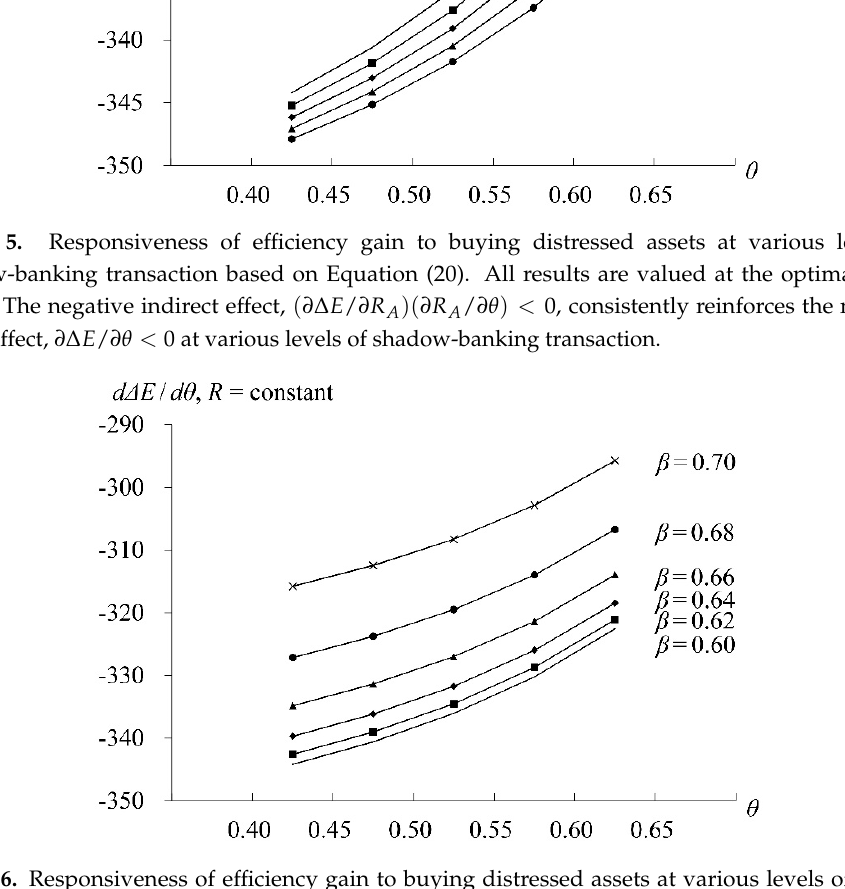
Figure 6. Responsiveness of efficiency gain to buying distressed assets at various levels of barrier based on Equation (20). All results are valued at the optimal R A of 5.60%. The negative indirect effect, ( ∂ ∆ E / ∂ R )( ∂ R ) < 0, consistently reinforces the negative direct effect, ∂ ∆ E / ∂θ < 0 at various levels of shadow-banking transaction.